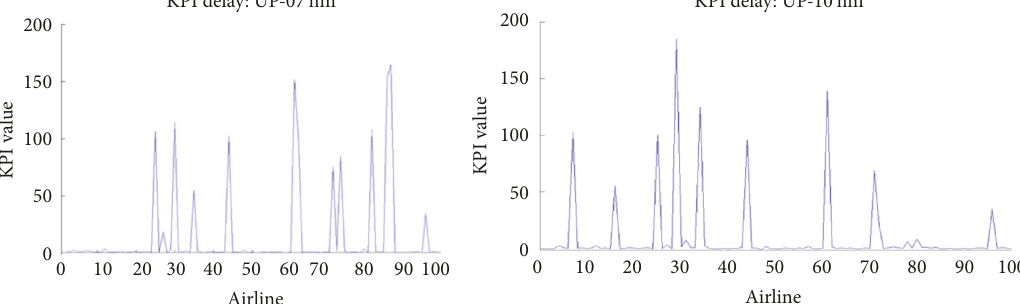
Figure 9: Average delay (in seconds) per airspace user for the analysis cases of 7 NM/100-AUs and 10NM/100-AUs.